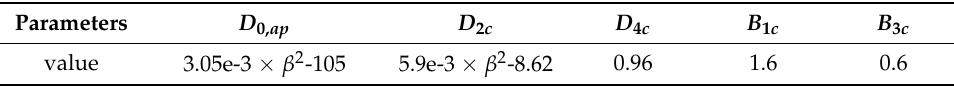
Figure 5. Variations of the model values for ( a ) 0, ap D and ( b ) D 2 c . Shadowed area for eclipse season. Table 4. Values for the empirical a priori SRP model expressed in Equation (14) (unit: nm/s 2 , β in degrees).